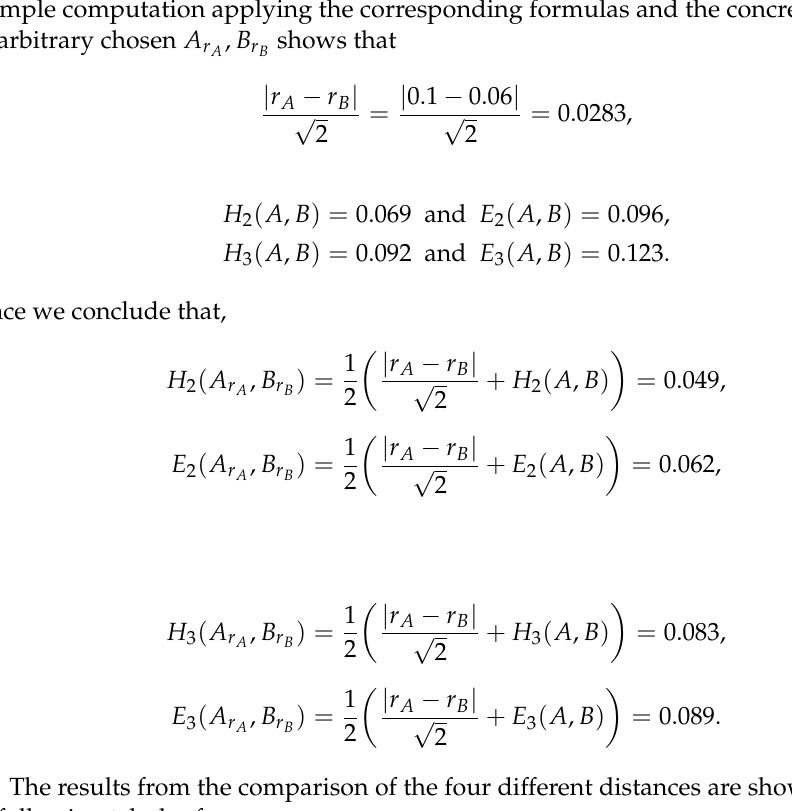
∈ C-IFS(E) with E = { 0,1,2 } , C , B r B A